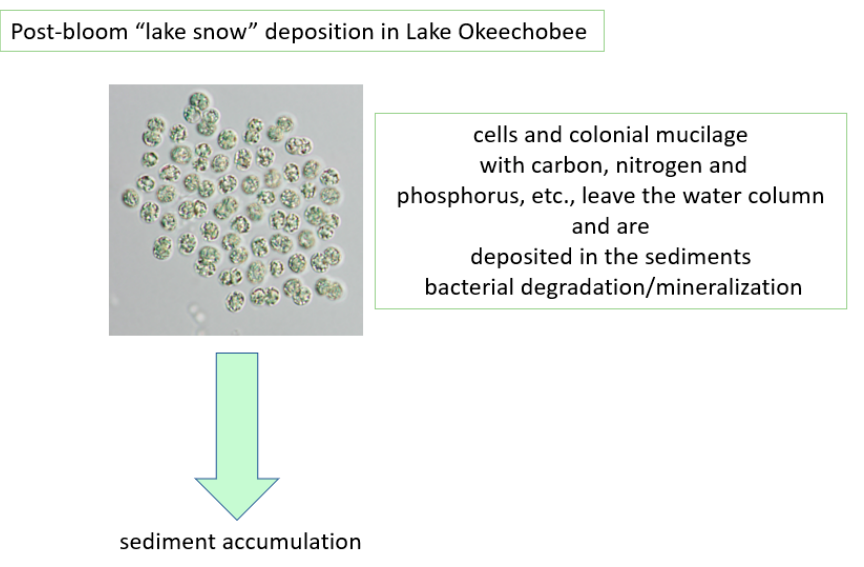
Figure 11. Nutrient sources that feed the algal blooms in Lake Okeechobee.